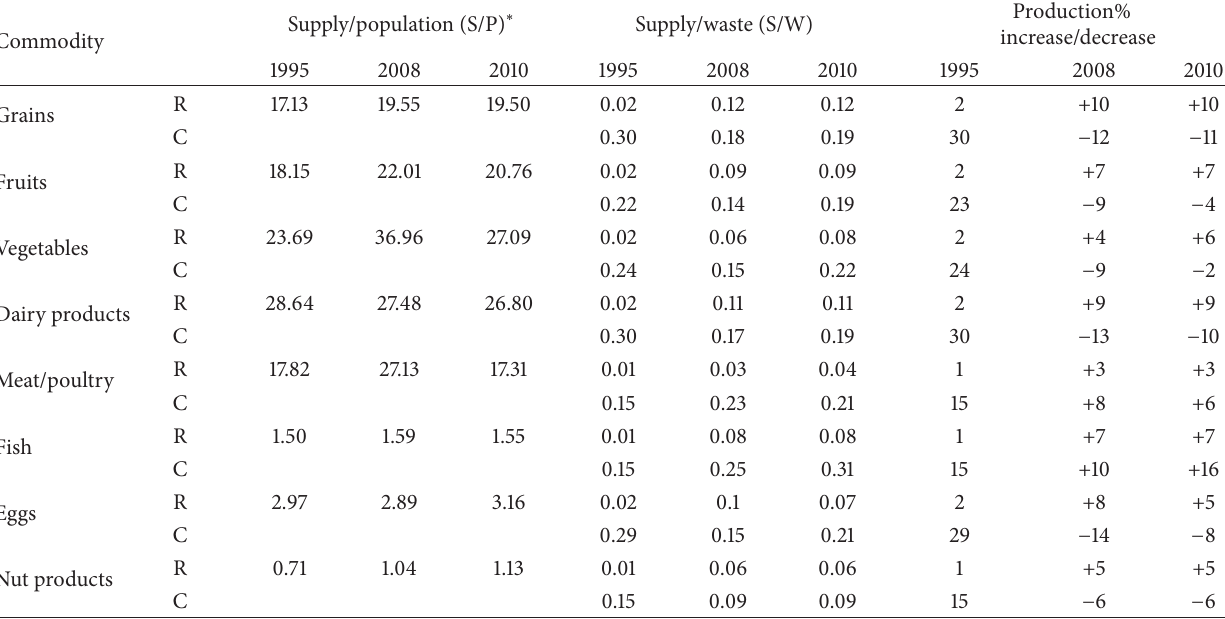
Table 4: Analysis of retail and consumer waste increase/decrease in the USA based on USDA data from [17, 58, 60].